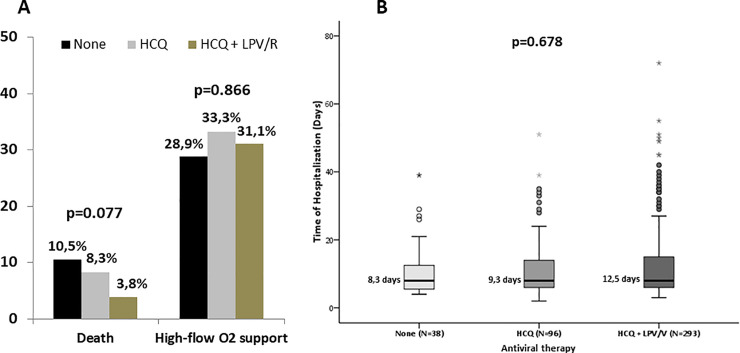
Mortality rate (panel A) and time of hospitalization (panel B) according to the antiviral therapy received.